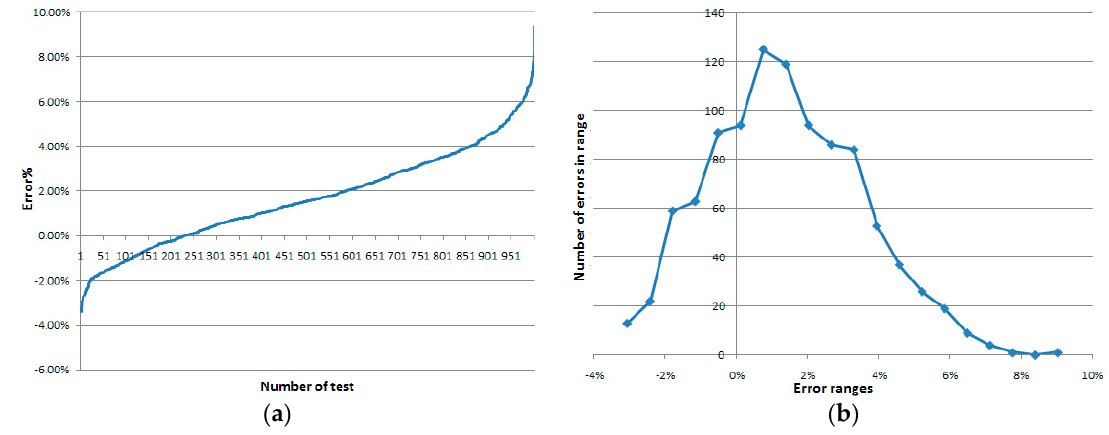
Figure 7. Analysis of the errors with UGMC for the case in Figure 4c after 1000 tests: ( a ) calculated and sorted errors and ( b ) histogram of those errors.